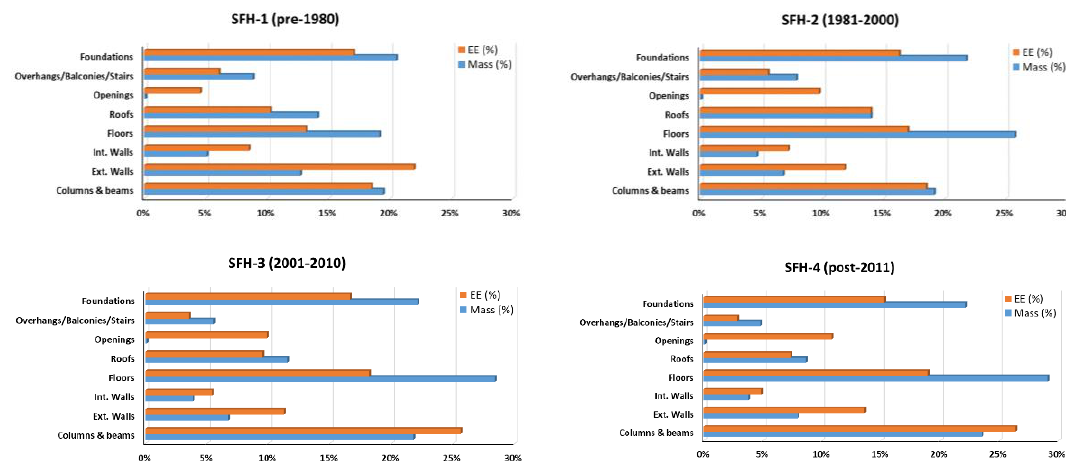
Figure 4. Percentage of the total building mass and embodied energy for the aggregated materials used in the main structural elements of the case studies and averaged for the four construction